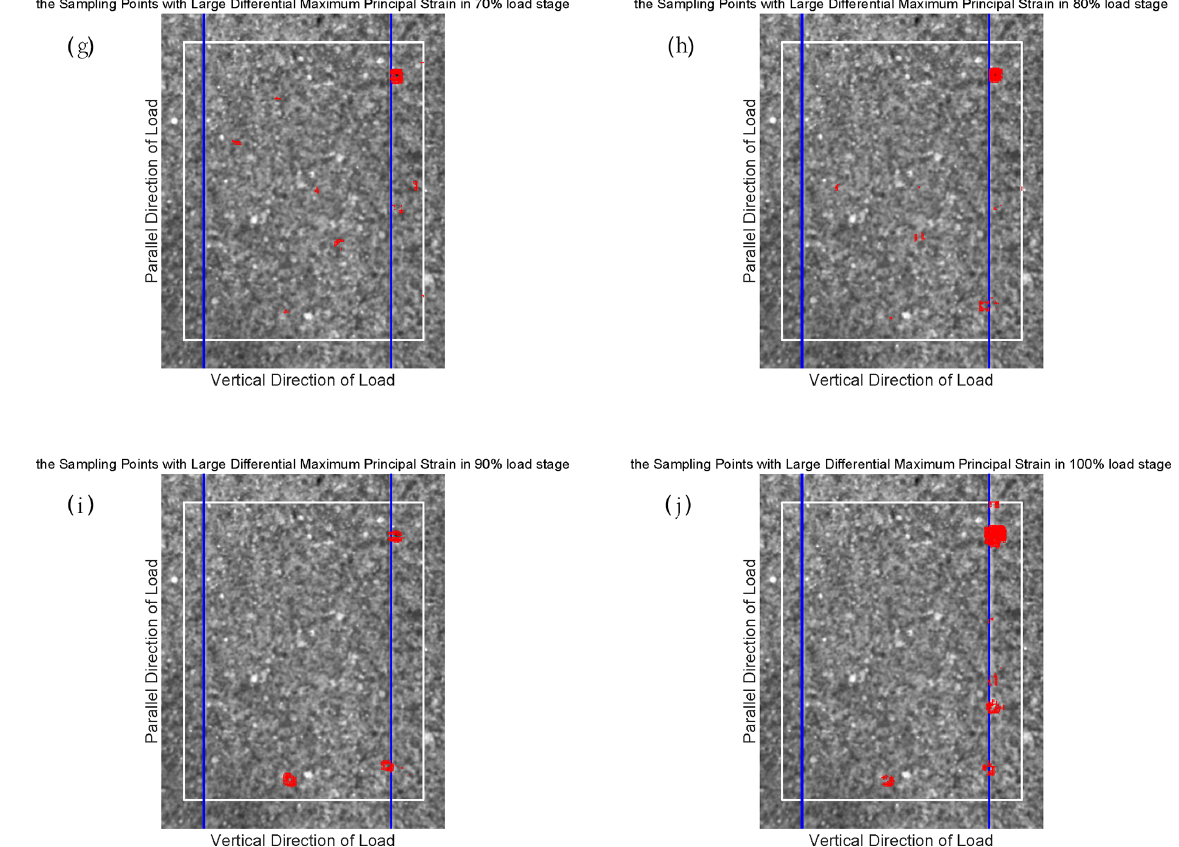
Figure B2. The position of the sampling points with large differential maximum principal strain for sample